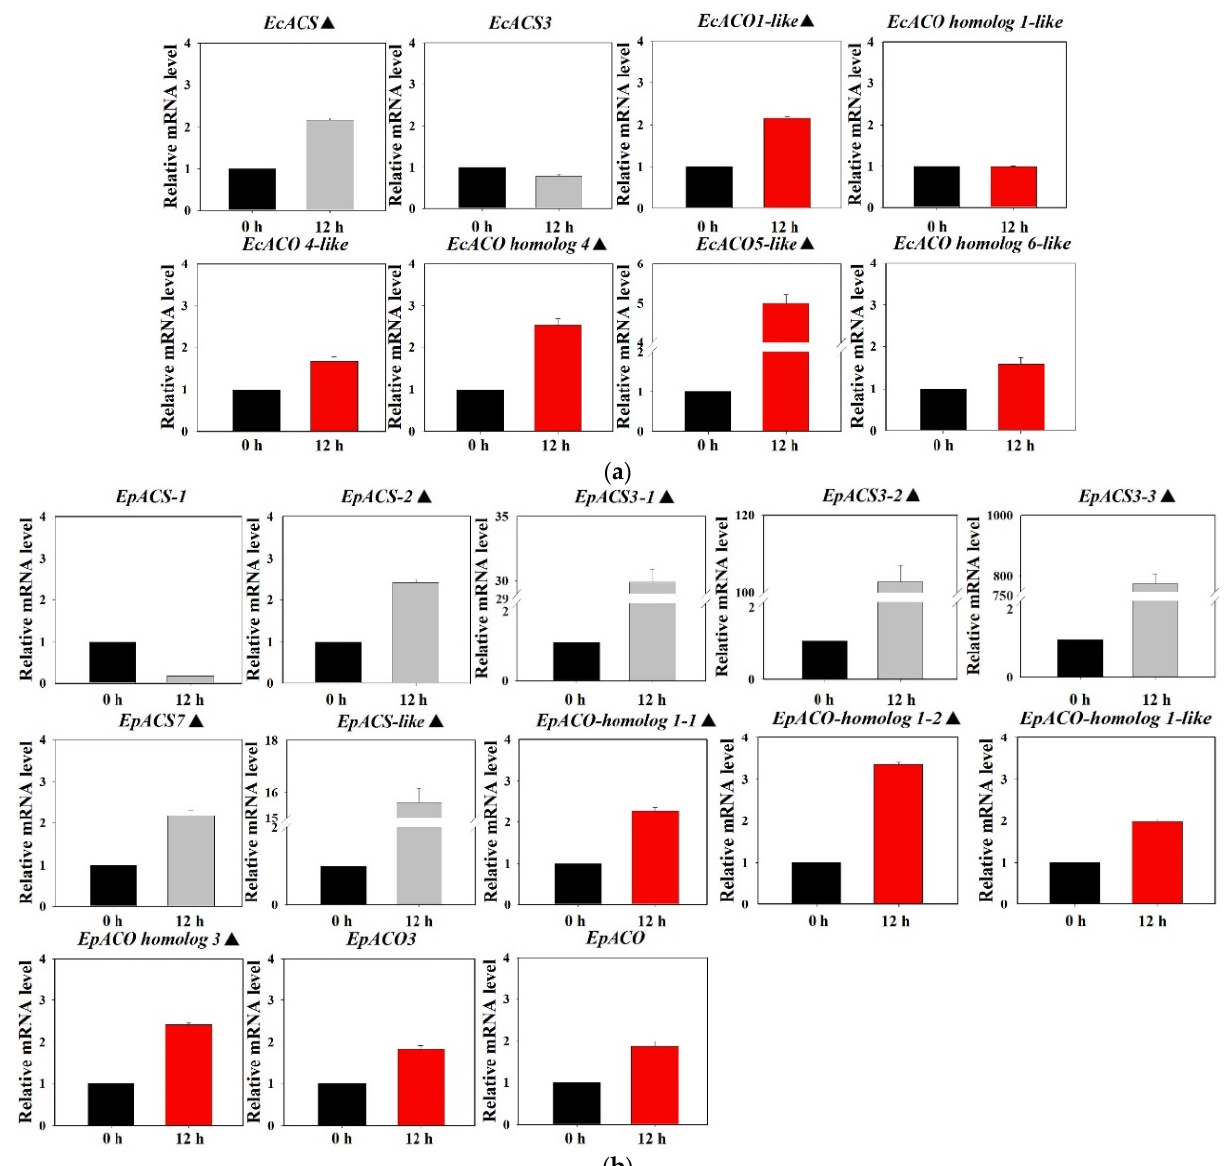
Figure 5. ACS and ACO gene expression patterns after florpyrauxifen ‐ benzoyl treatment. The X ‐ axis represents the time after florpyrauxifen ‐ benzoyl treatment. The Y ‐ axis represents transcript levels relative to 0 h untreated with florpyrauxifen ‐ benzoyl. Data are the mean values of six technical and biological replicates. The standard errors of the means are described by Vertical bars represent standard errors of the means. The icon “ ▲ ” represents genes that were up ‐ regulated more than 2 fold by florpyrauxifen ‐ benzoyl and significant high than the untreated control group (0 h). ( a ) ACS and ACO gene expression patterns in barnyardgrass. ( b ) ACS and ACO gene expression patterns in yerbadetajo.